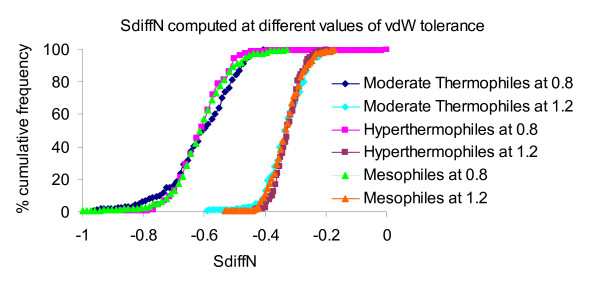
Lack of separation by SdiffN. SdiffN is shown for mesophile, moderate thermophile, and hyperthermophile proteins, at two values of the van der Waals tolerance parameter (used in sidechain packing), 0.8 and 1.2 Å.